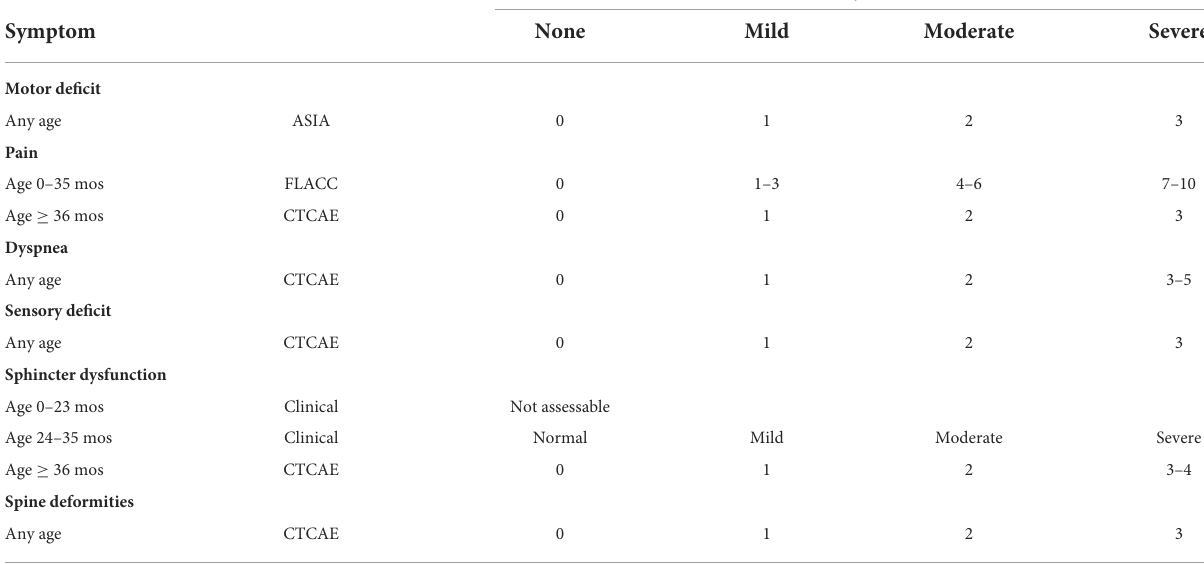
TABLE 1 Harmonization of severity scores for symptom